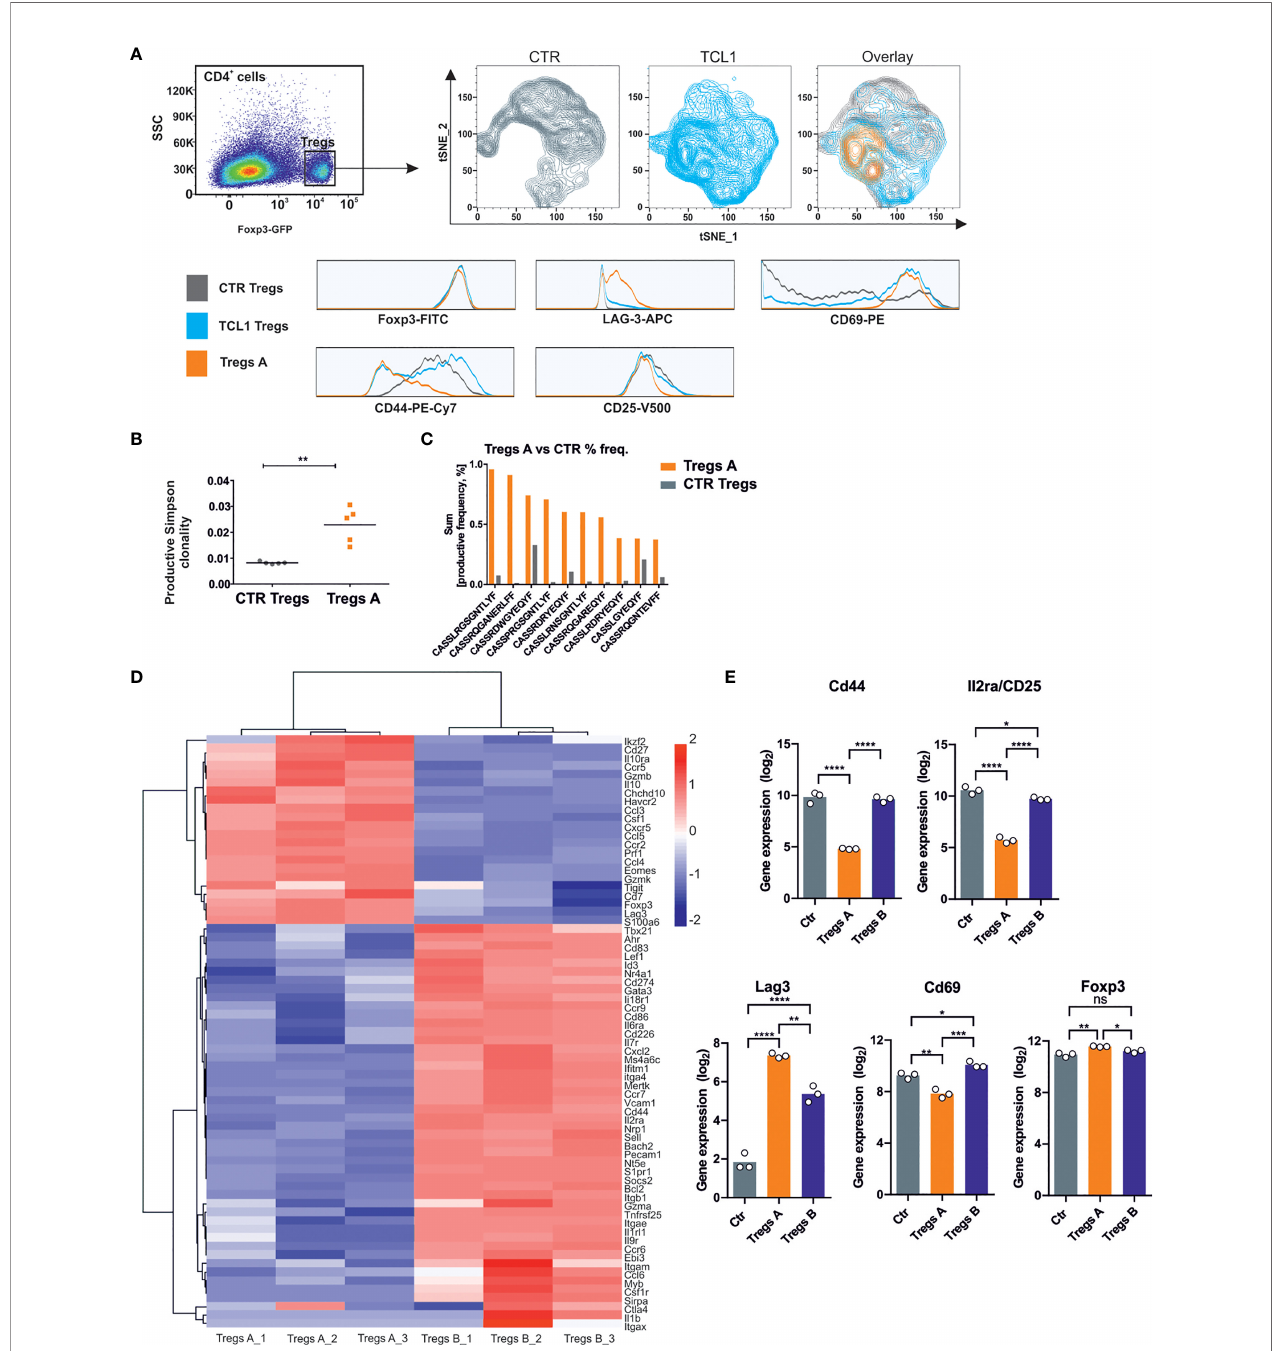
FIGURE 3 | A speci fi c Tregs population is formed during the progression of TCL1 leukemia. (A) tSNE analysis of Tregs phenotype isolated from control (grey) and TCL1 leukemia-bearing (blue) B6 Foxp3 EGFP mice 14 days after injections with leukemic cells. The overlay of counterplots presents the Tregs subpopulation, speci fi c for TCL1 leukemia-bearing mice (Tregs A, orange). The Tregs GFP + -were plot on the graphs according to the expression of CD44, CD69, CD25, and LAG-3 that are presented on the histograms. The counter plots show representative analysis of Tregs from 2 control and 4 TCL1 leukemia-injected mice. (B) The productive Simpson clonality of Tregs sorted from control (all Tregs, CTR Tregs) and TCL1 leukemia-bearing (the speci fi c TCL1-associated Tregs subpopulation, Tregs A) DEREG mice, n = 5. (C) The productive sum frequency of top 10 amino acid sequences of CDR3 TCR b of Tregs A which were present in all of tested TCL1 leukemia-bearing DEREG mice, n = 5. (D) Clustering of selected DEGs between Tregs A and Tregs B (RNA sequencing with FDR < 0.05 and log 2 FC > 1) by correlation with complete linkage, n = 3. (E) Gene expression (log2, RNA sequencing) of genes from panel A in Tregs from CTR and TCL1 leukemia-bearing mice, n = 3. One-way ANOVA * p ≤ 0.05, ** p< 0.01, *** p<